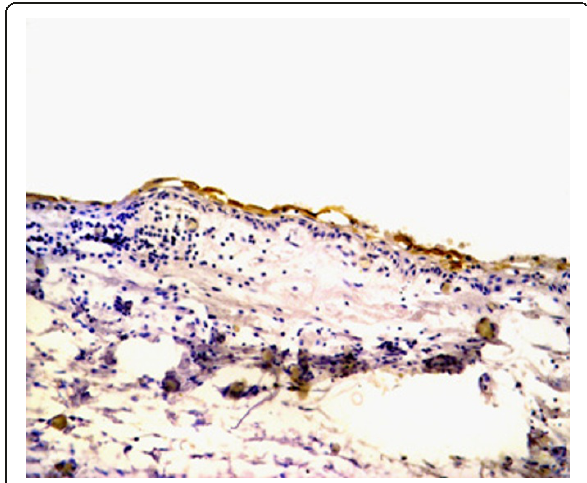
Figure 1 Photomicrograph of DC showing cytoplasmic & membranous immunopositivity of superficial epithelial cells (Anti-CD10.Original magnification x40) .